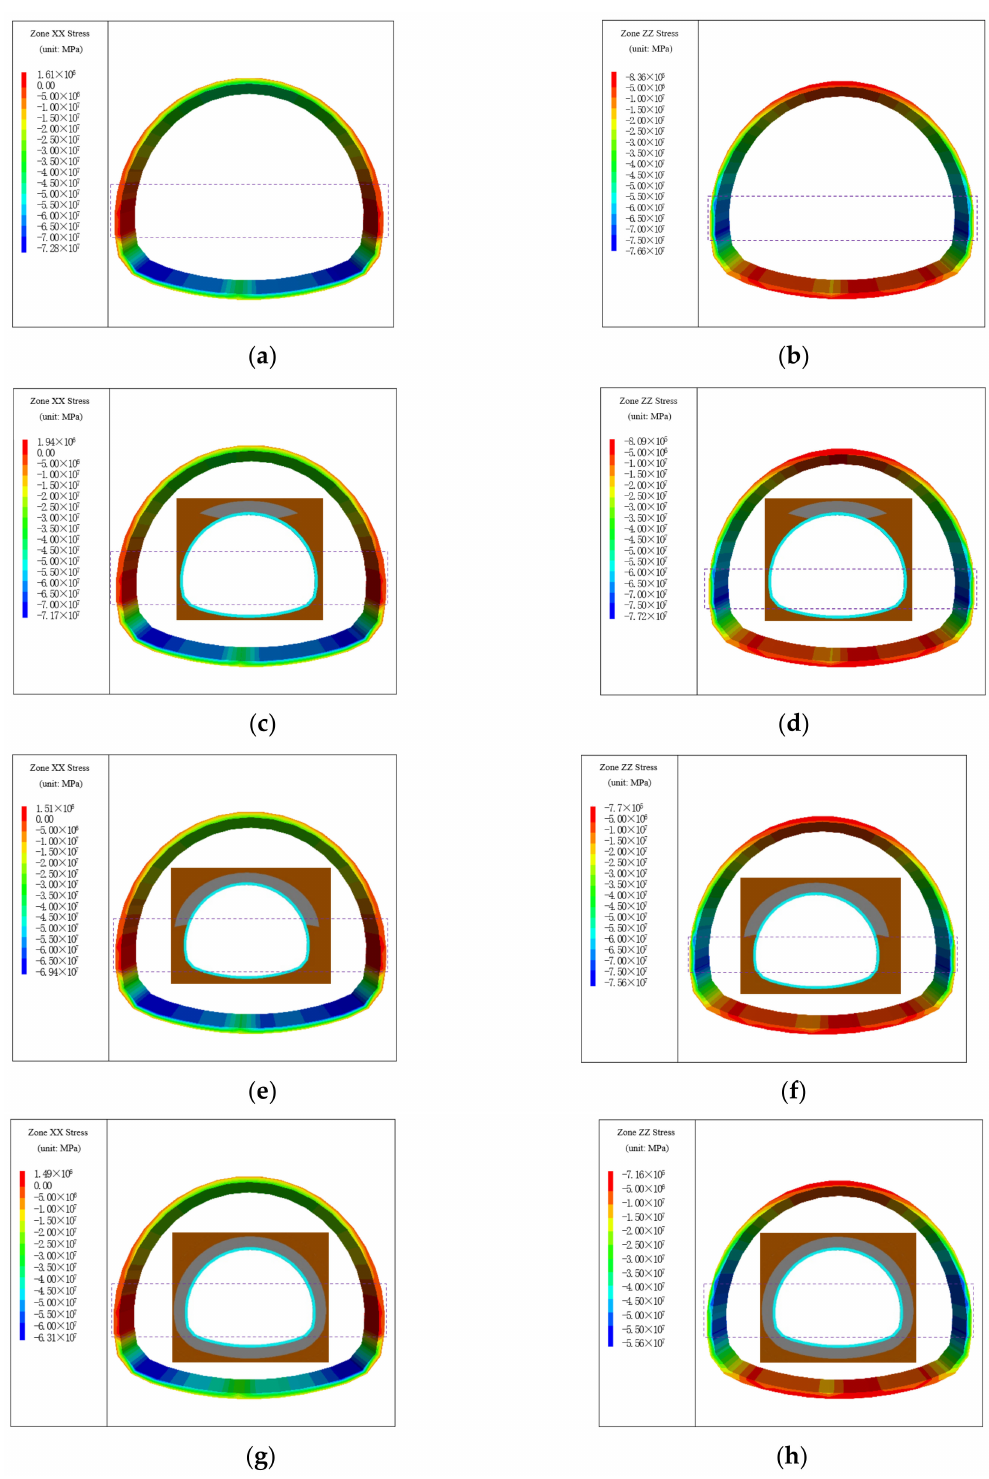
Figure 10. Cloud diagrams of the total stress of the primary support and total vertical stress of the surrounding rock under four different grouting ring ranges. ( a ) Cloud diagram of σ xx under no grouting; ( b ) Cloud diagram of σ zz under no grouting; ( c ) Cloud diagram of σ xx under 1/4 ring grouting; ( d ) Cloud diagram of σ zz under 1/4 ring grouting; ( e ) Cloud diagram of σ xx under 1/2 ring grouting; ( f ) Cloud diagram of σ zz under 1/2 ring grouting; ( g ) Cloud diagram of σ xx under full-ring grouting; ( h ) Cloud diagram of σ zz under full-ring